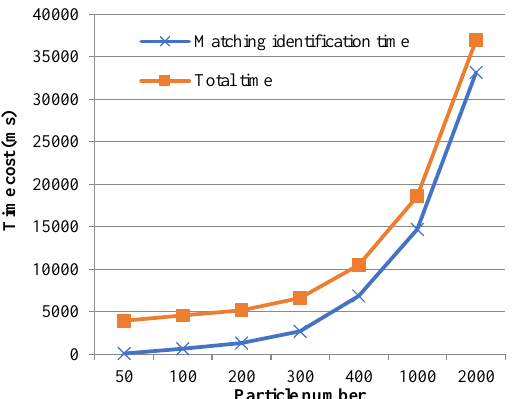
Figure 5. Matching identification time and total time cost under different particle numbers using Area 7 (439 nodes) as an example. The thread number differed in the two parallel stages.